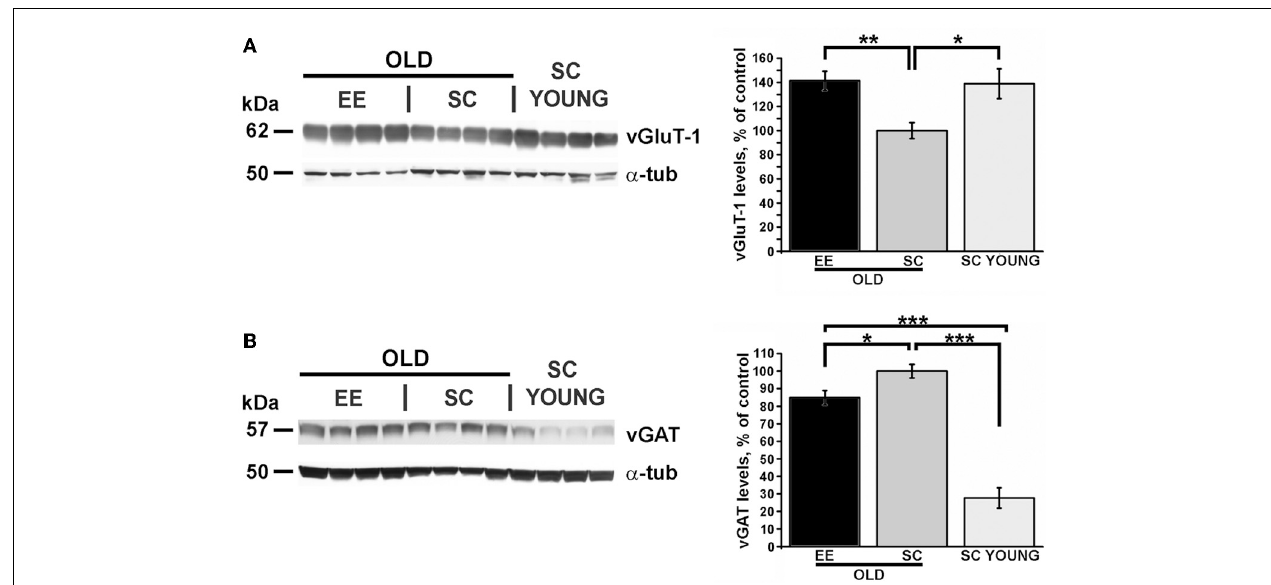
∗ p = 0 . 035, ∗∗ p = 0 . 004). (B) Left, representative immunoblotting and right, quantification of the vGAT GABA transporter expression. While the SC-OLD group displayed a increased expression level compared to SC-YOUNG mice, this increase was partially counteracted in EE-OLD animals (One-Way ANOVA, p < 0 . 001, followed by Tukey’s post-hoc test, ∗ p = 0 . 041, ∗∗∗ p < 0 .